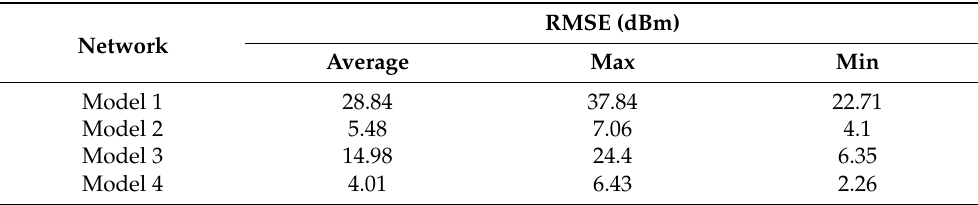
Table 7. Accuracy of Radio-map Generation for Each